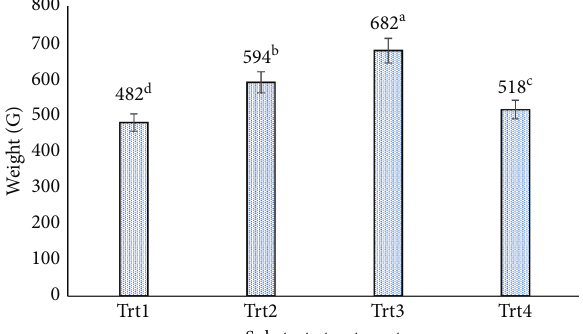
Figure 3: Biological yield as affected by substrate treatment. Means with different letters are significantly different at p < 0 . 05. Trt fruit shells, Trt 2 � wheat straw, Trt 3 � sawdust, and Trt 4 � maize